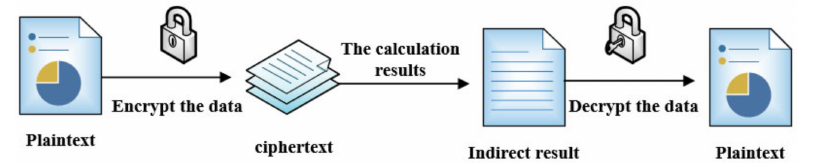
Figure 1. Basic flow chart of data encryption and decryption.